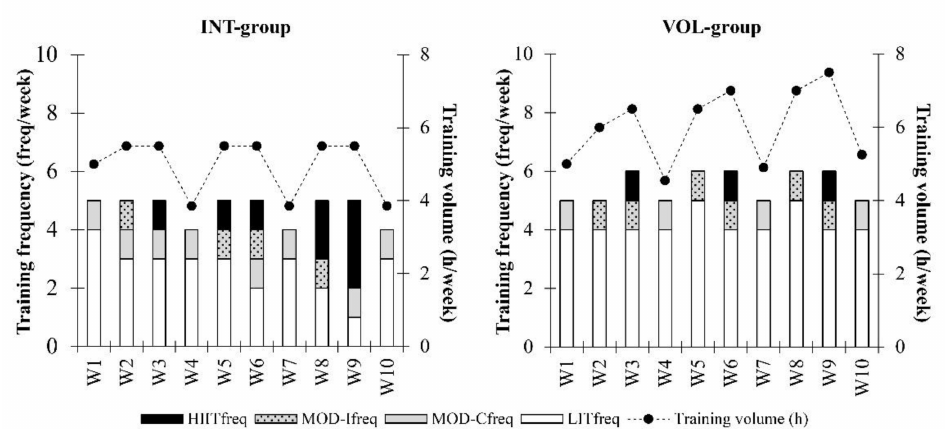
Figure 1. Training program progression of a representative participant in the INT- and VOL-groups. INT, Intensity-group; VOL, Volume-group; HIITfreq, frequency of high-intensity interval training; MOD-I, frequency of moderate-intensity interval training; MOD-Cfreq, frequency of moderate- intensity continuous training; LITfreq, frequency of low-intensity